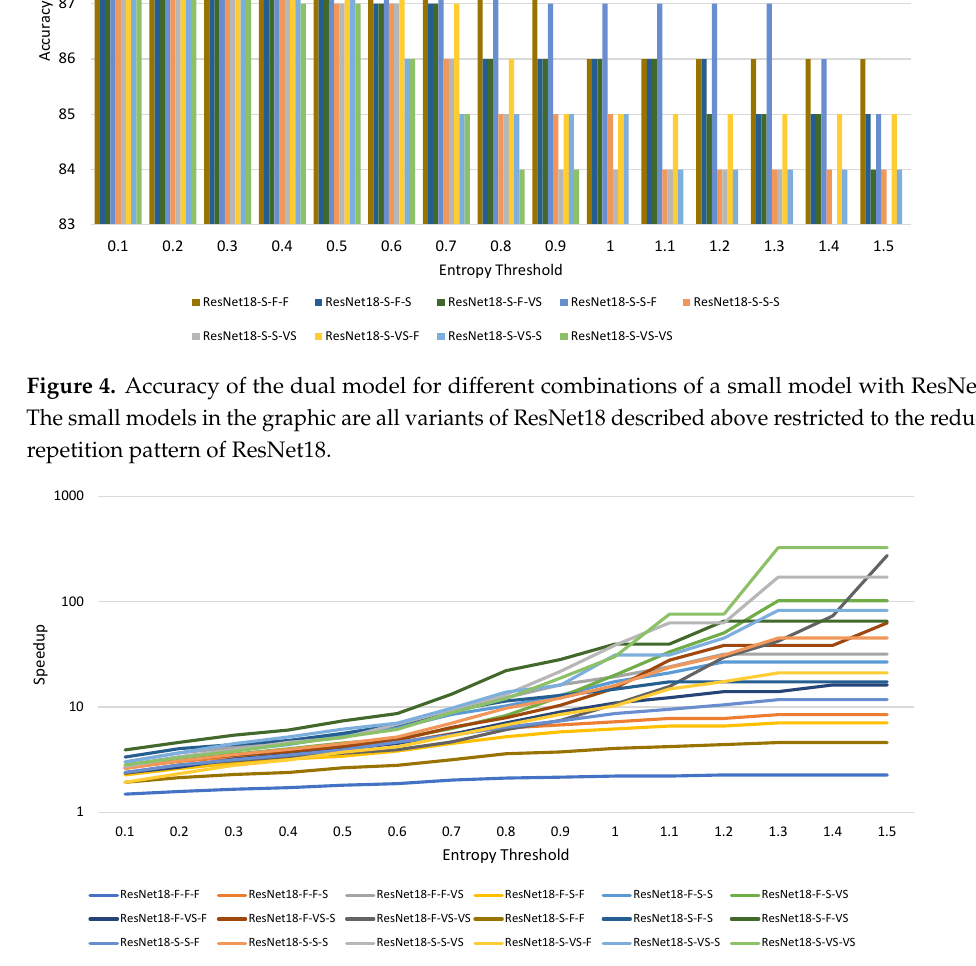
Figure 5. Speedup of the dual model for different combinations of a small model with ResNet50.